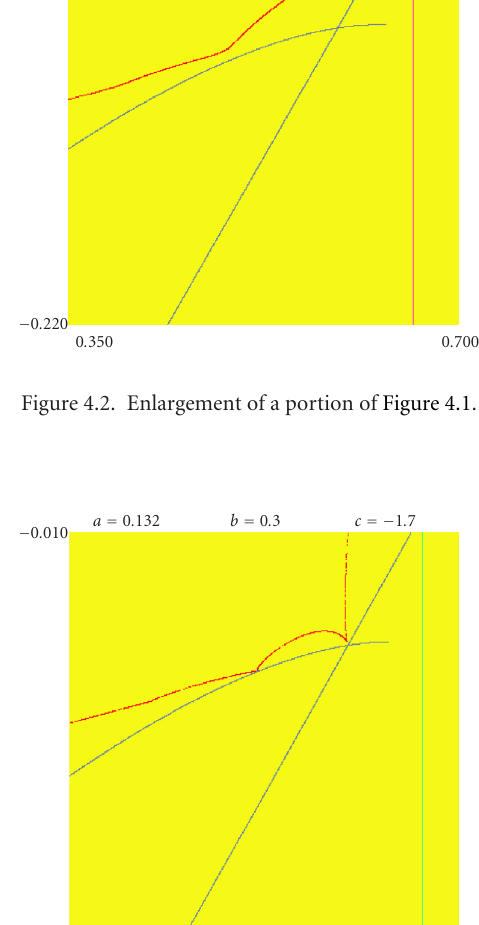
the prefocal curve and then the focal point. An enlargement of a portion of the attractor, close to the prefocal curve, is illustrated by Figure